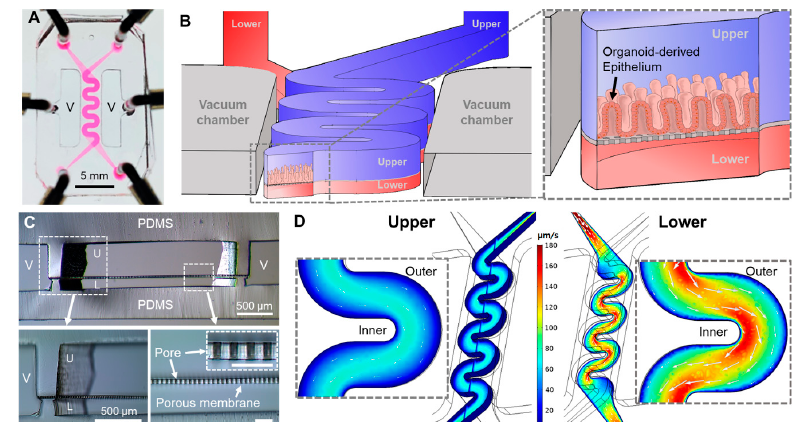
Figure 1. The configuration of a physiodynamic mucosal interface-on-a-chip (PMI Chip). ( A ) A photograph of a PMI Chip device. The culture medium was filled in the upper and lower microchannels to visualize the convoluted design of microchannels. ( B ) A 3D layout of a PMI Chip and a zoom-in cross-sectional view illustrate the structural configuration of the convoluted microchannel that contains an organoid-derived 3D epithelial layer. The upper (blue) and lower (red) microchannels mimic the lumen and capillary compartments in the gut, respectively. ( C ) The cross- sectional micrographs of a PMI Chip (upper panel) and the zoom-in insets (lower panel) that highlight the white dashed boxes in the upper panel. An inset in the lower right panel shows a cross-cut view of a PDMS porous membrane (Bar, 50 µm). V, vacuum chamber; U, upper microchannel; L, lower microchannel. ( D ) The velocity profiles of fluid flow (unit, µm/s) in the upper and lower microchannels at 50 µL/h. White arrows in the zoom-in insets indicate the direction of the fluid flow and the magnitude of a linear flow rate.